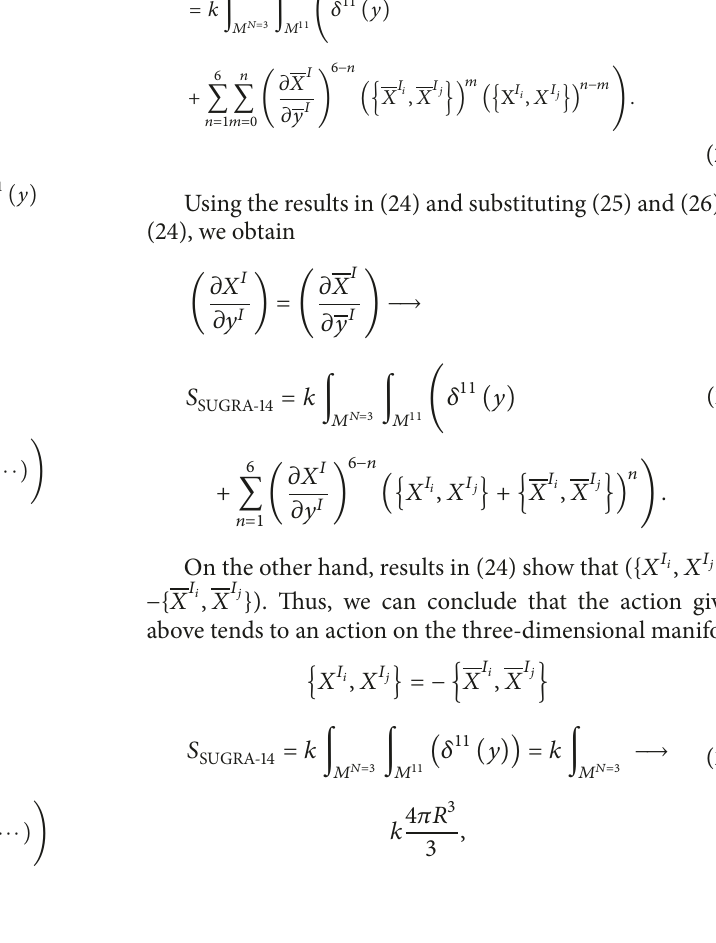
where 𝑘 is a constant. There are similar results for other terms in 14-dimensional